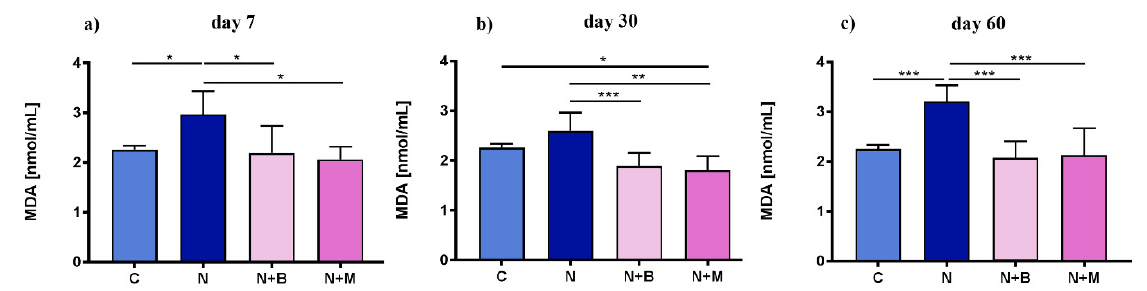
Figure 2. Content of malondialdehyde (MDA) in erythrocytes’ membrane under acoustic stress conditions after 7, 30, and 60 days. Animals ( n = 6) were treated for 60 days with noise (N) or left untreated (C). Mesedin (M) and beditin (B) were injected daily i.p. to the rats exposed to chronic noise (N + M and N + B, respectively). One-way ANOVA with Sidak’s multiple comparison test, * p < 0.05, ** p < 0.01, *** p < 0.001. The mean ± SEM values of erythrocytes’ membrane content of MDA on days 7, 30, and 60 after exposure of noise and mesedin/beditin are shown in ( a ), ( b ), and ( c ), respectively.